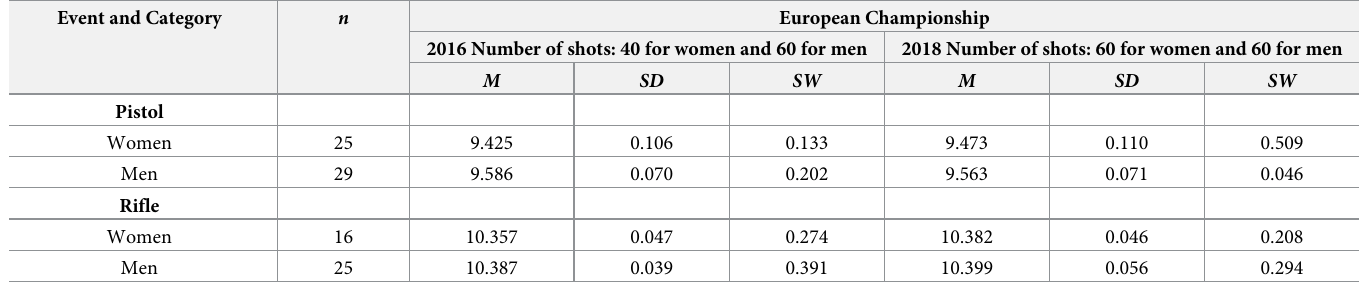
Table 3. Results of the shooters who participated in both championships. Data for paired t -tests. Event and Category n European Championship 2016 Number of shots: 40 for women and 60 for